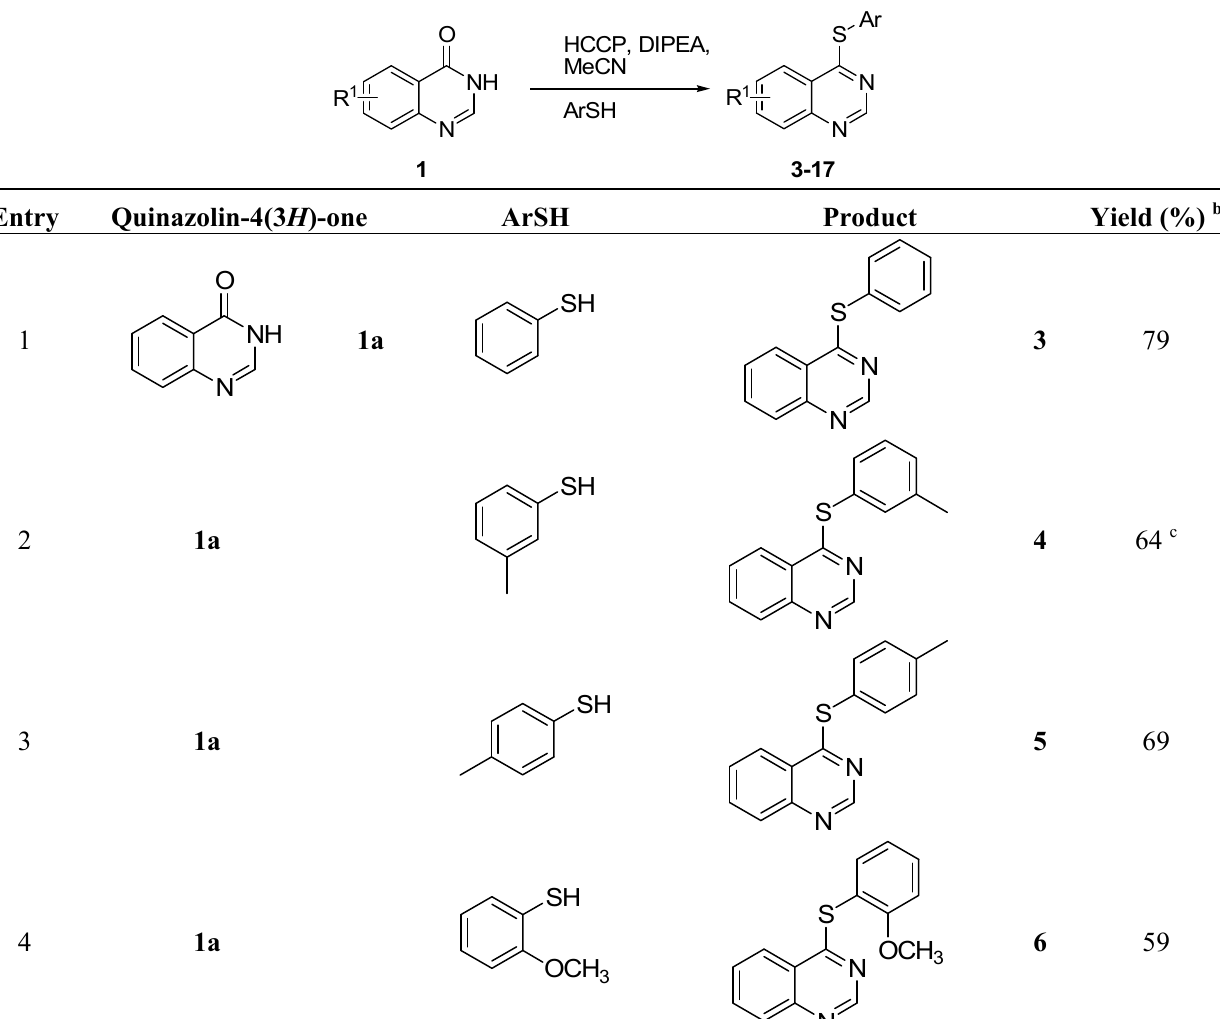
Table 2. HCCP-mediated formation of quinazoline thioethers from quinazolin-4(3 H )-ones a